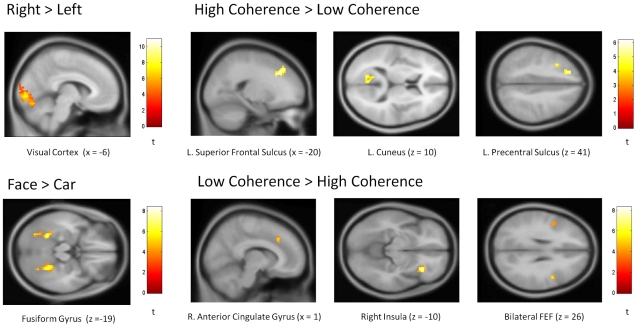
Group-level fMRI GLM results.The respective statistical parametric maps (thresholded at p<0.001 (uncorrected, voxel level), extent threshold 15–20 voxels) are overlaid on the group MNI template.